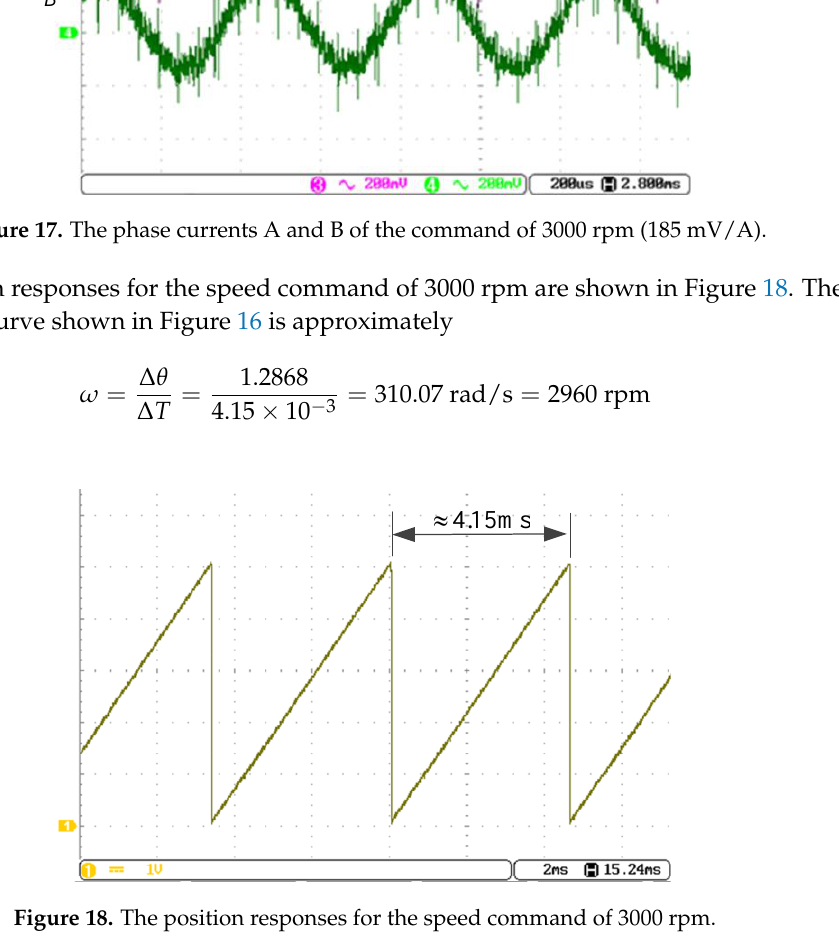
Figure 18. The position responses for the speed command of 3000 rpm.